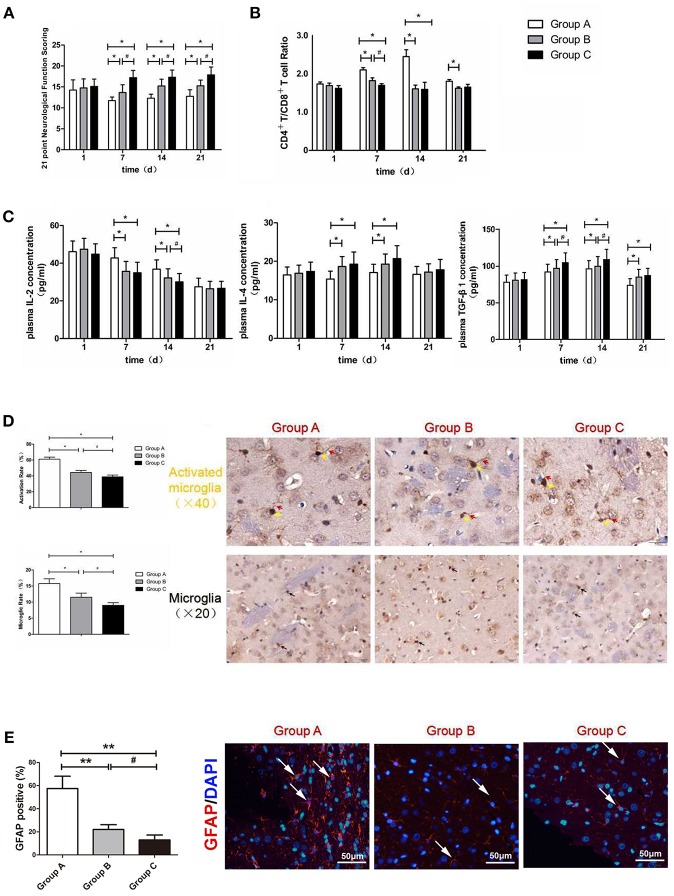
(A) Neurological function scoring histogram. (B) Histogram of peripheral blood CD4+T/CD8+T cell ratios. (C) Histogram of the proinflammatory cytokine IL-2, IL-4, and TGF-β1.*compared with Group A, P < 0.05; #compared with Group B, P < 0.05. (D) Iba-1 expression scoring of microglial cells measured at 21 d after SBI. *compared with Group A, P < 0.05; #compared with Group B, P < 0.05. The brown-positive cells are activated microglial cells, the yellow arrows indicate the somata of the activated microglia, and the red arrows indicate the processes of the activated microglia (x40). The black arrows indicate positive results (the brown cells) (x20). The scale bars are 20 μm. (E) GFAP expression scoring of astrocytes measured at 21 d after SBI. *compared with Group A, P < 0.05, **compared with Group A, P < 0.01; #icompared with Group B, P < 0.05. The scale bars are 50 μm.